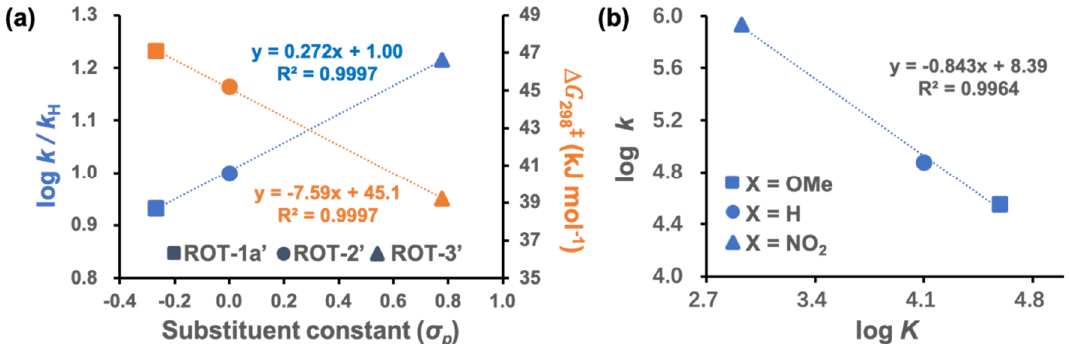
Figure 4. ( a ) The rotational frequency log k/k H and the activation Gibbs free energy correlate linearly with the substituent constant. ( b ) The correlation between binding constants of C2 , C3 and C4 and the rotational frequencies log k of ROT-1a’ , ROT-2′ and ROT-3′ .